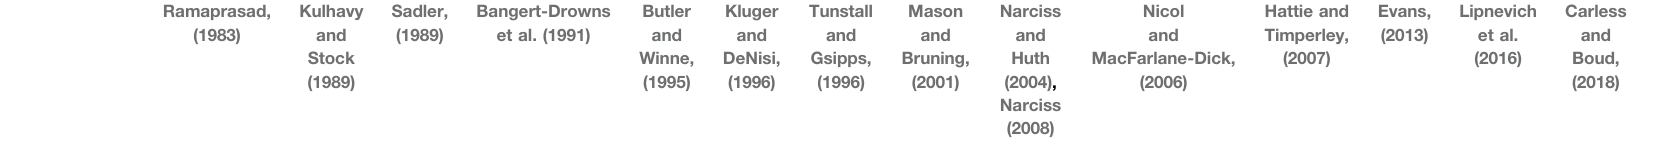
TABLE 1 | Cross-citations of articles included in the current review.